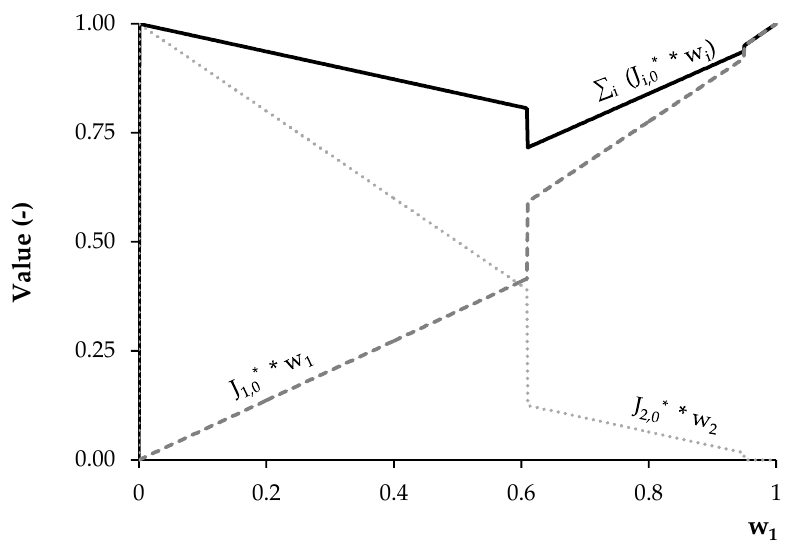
Figure 3. Performance of the two-objectives function and its components in the current situation.